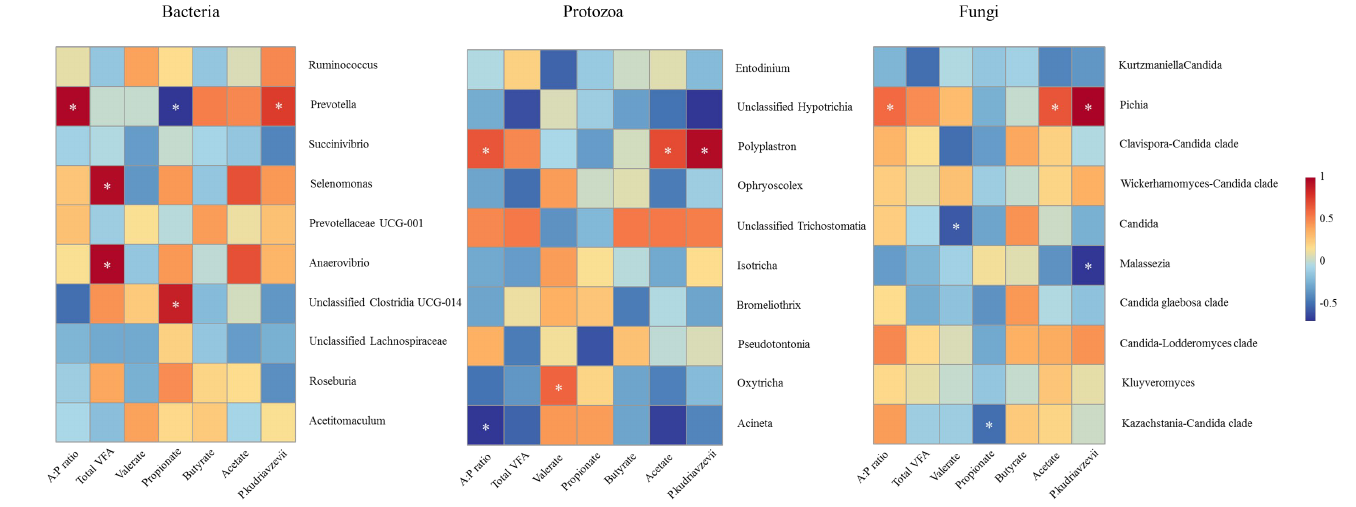
Figure 6. Spearman rank correlation analysis between rumen microbial community (top 10 relative abundance at the genus level of bacteria, protozoa and fungi), Pichia kudriavzevii and rumen volatile acids. Red, positive; blue, negative. * p < 0.05.